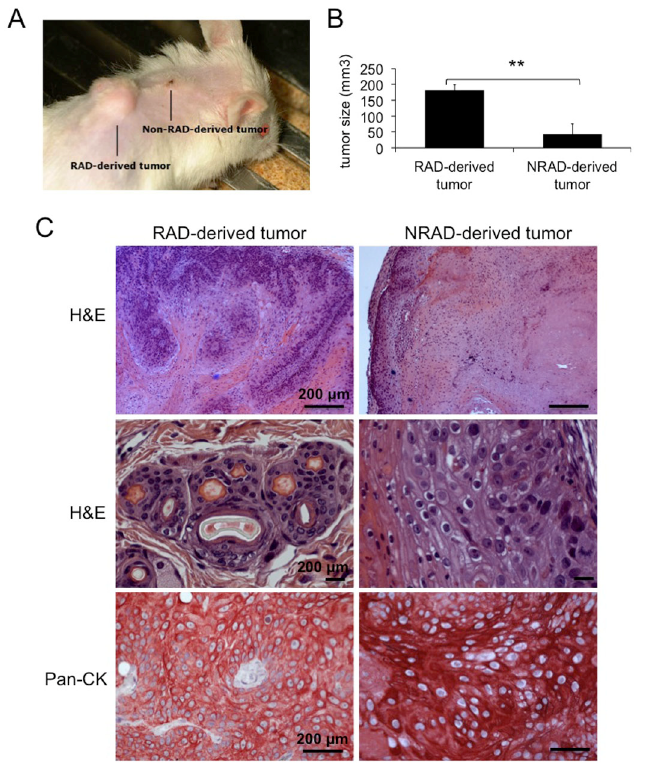
Figure 6. Tumorigenic ability of cSCC cells subpopulations in vivo. ( A ) Representative picture of RAD and NRAD-derived tumors formed by xenografting cSCC keratinocytes onto NOD/SCID mice; ( B ) Size of RAD and NRAD derived tumors as measured in three independent experiments. * p < 0.05, ** p < 0.01; ( C ) Hematoxilin & Eosin and Pan-cytokeratin (CK) staining of RAD and NRAD-derived tumors. Scale bars = 200 μ